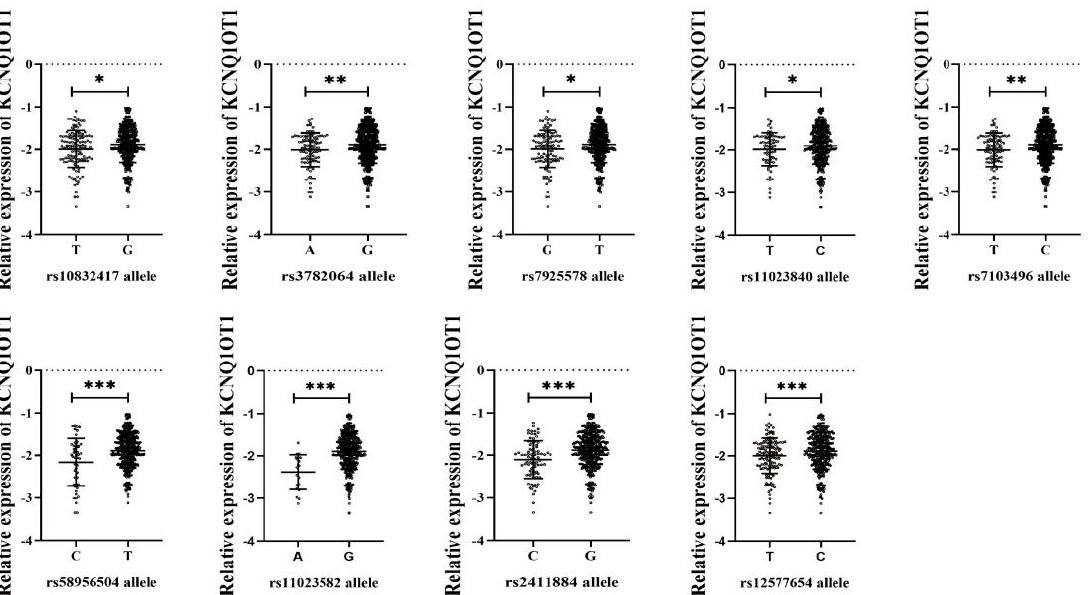
Figure 3. Comparison of SNP alleles regarding lncRNA KCNQ1OT1 expression level. * p <